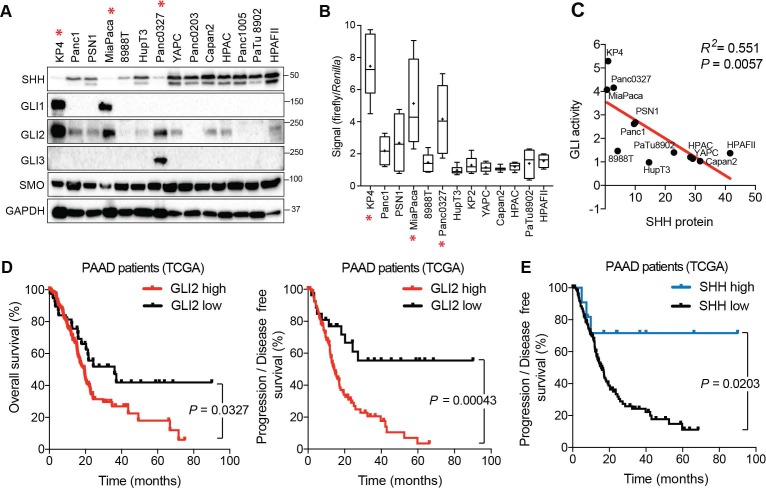
Expression and activity of GLI proteins is anti-correlated with Hh ligand levels in PDA.(A) Immunoblots showing expression of the indicated proteins in 14 human PDA cell lines. Cell lines denoted with an asterisk represent GLIhi/Hhlo lines. (B) The indicated cell lines were transfected with the 8 × 3’Gli-binding site luciferase plasmid and luciferase activity was measured 48 hr post-transfection. For each box-and-whisker plot, center asterisk indicates the mean of n = 3 experiments with a total of 10 independently transfected cultures for each cell line. (C) GLI activity as measured by GLI luciferase assay (B) is anti-correlated with SHH protein levels (A). Linear regression line is shown in red along with corresponding statistics. (D,E) High expression of GLI2 predicts shorter overall (D: left; GLI2 high n = 147, GLI2 low n = 38) and disease-free (D: right; GLI2 high n = 114, GLI2 low n = 27) survival while high SHH expression predicts extended disease-free survival (E: SHH high n = 11, SHH low n = 130) for patients with PDA from The Cancer Genome Atlas (TCGA). Data from 185 patients. p-Value calculated by Log-rank test.10.7554/eLife.45313.005Figure 1—source data 1.GLI proteins are expressed in basal-like PDA.